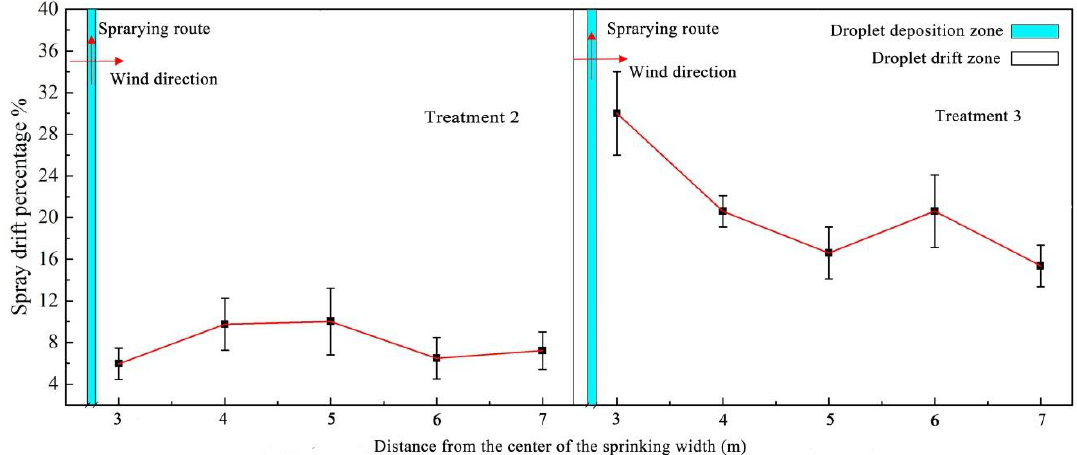
Figure 6. Distribution of droplet drift at different flying heights. Note: Treatments 2 and 3 were low-height and low-volume spraying by the UAV at working heights of 1.5 and 2 m above the canopy.